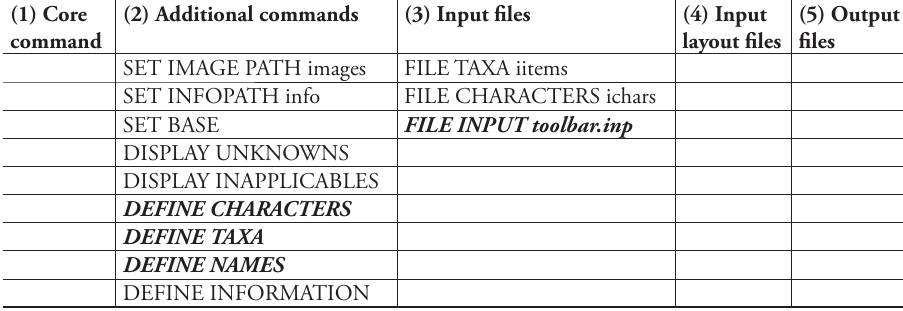
Table 8. Classifi cation of commands used in the Intkey.ink directive fi le. Reference numbers used in Fig. 35 are given in the header of the table. Th e command in bold and italics may require changes being made by the